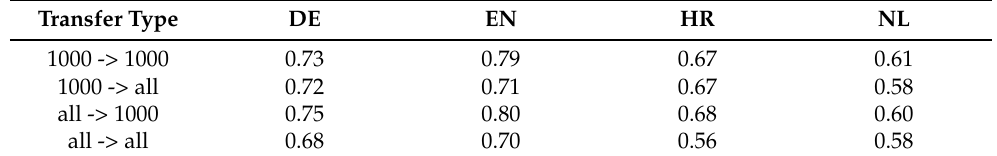
Table A4. Spearman’s correlation coefficients derived by MS-MiniLM model, transfer from Russian.